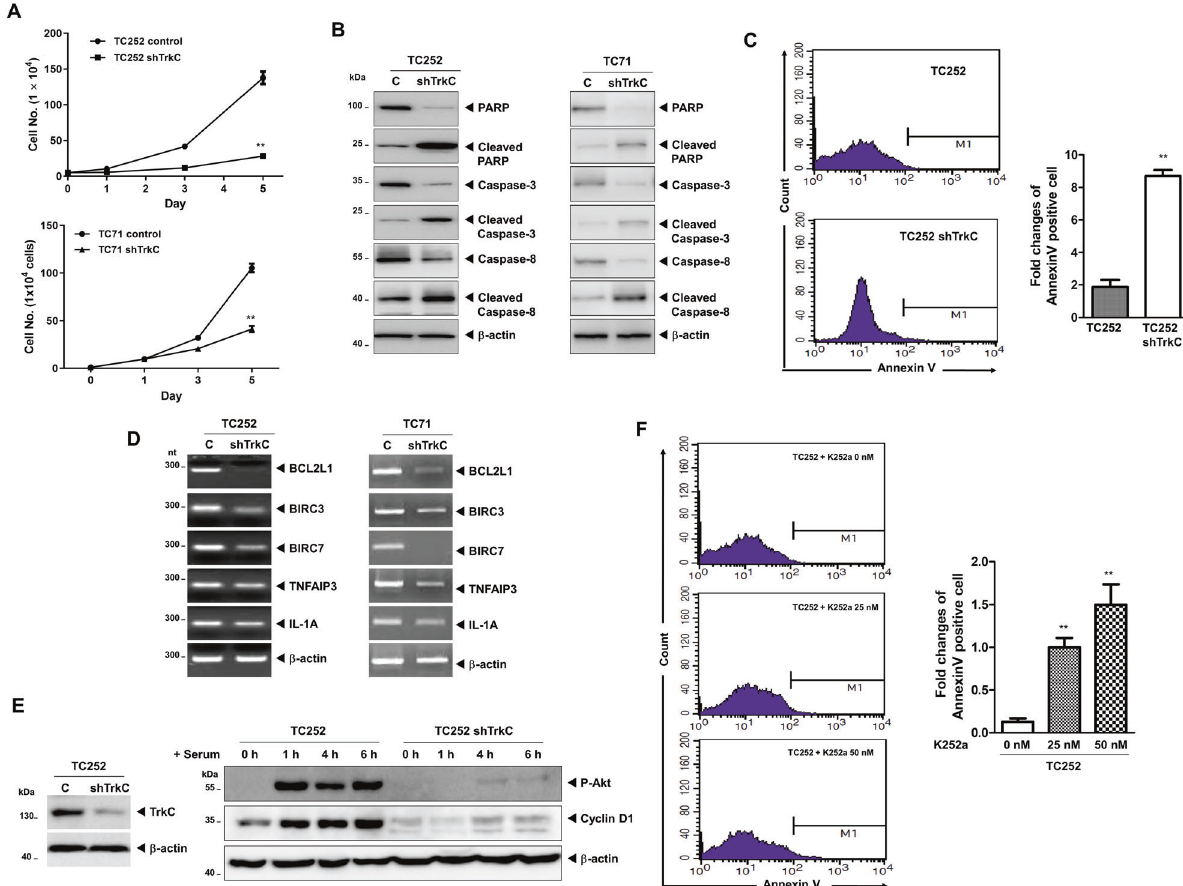
(Fig. 3F). These results indicated that the expression-mediated induction of tyrosine kinase activity of TrkC is critical for the survival and tumorigenicity of ES